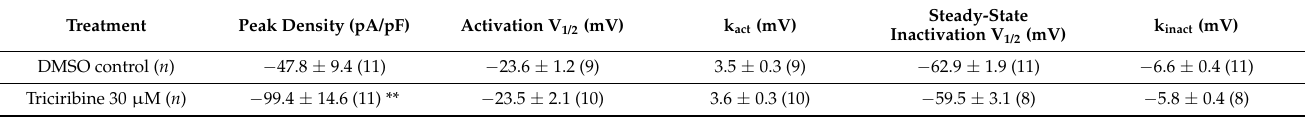
Table 1. Effects of triciribine on Na v 1.6 properties in HEK-Na v 1.6 cells a .